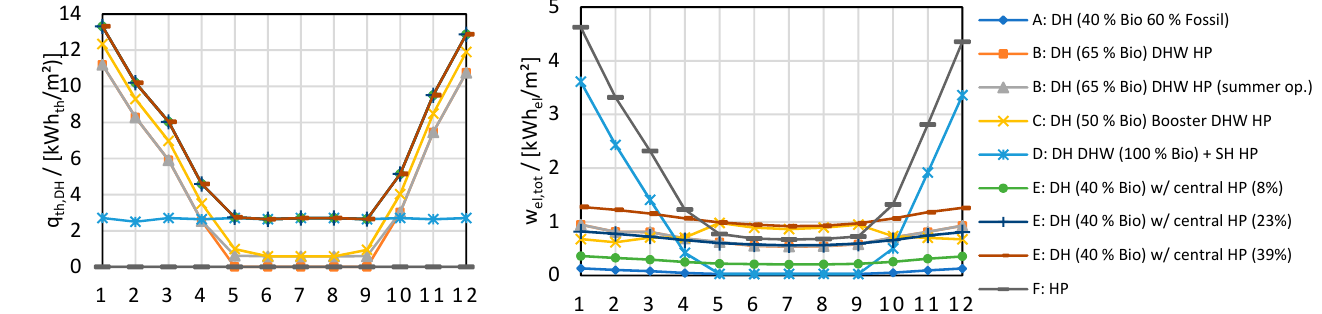
Figure 16. Total specific thermal demand of DH ( left ) and total specific electricity demand ( right ) for the different integration options (A through F).